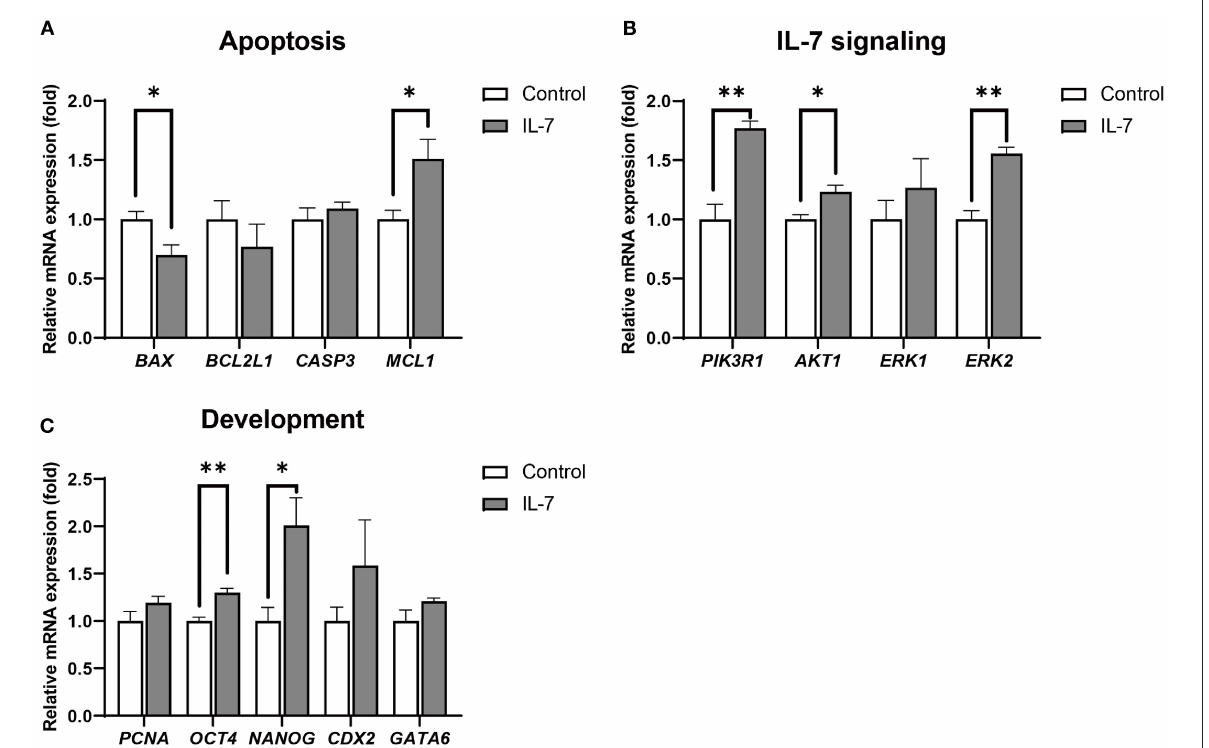
FIGURE6 Relative mRNA expression levels of genes associated with apoptosis, IL-7 signaling, and development in IL-7-treated blastocysts. The mRNA expression levels of (A) apoptosis-related genes ( BAX , BCL2L1 , CASP3 , and MCL1 ), (B) IL-7 signaling-related genes ( PIK3R1 , AKT1 , ERK1 , and ERK2 ) and (C) development-related genes ( PCNA , OCT4 , NANOG , CDX2 , and GATA6 ) in blastocysts from control and 10ng/mL IL-7 treatment group. Data were normalized to the RN18S gene expression. Asterisks indicate statistical significance (* p < 0.05 and ** p < 0.01). For all graphs, the value represents mean ± SEM. The experiments were replicated three or four